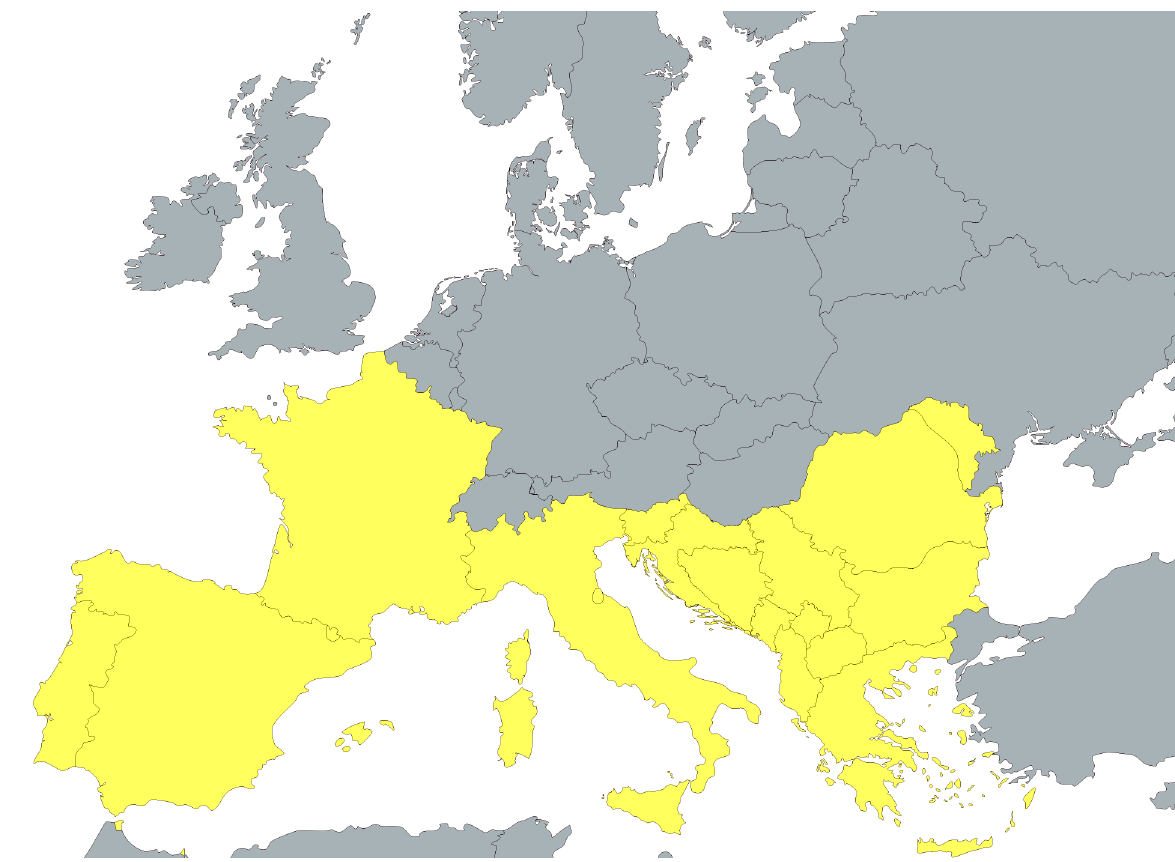
Fig 1. Southern Europe. Map of Southern Europe. Figure created with